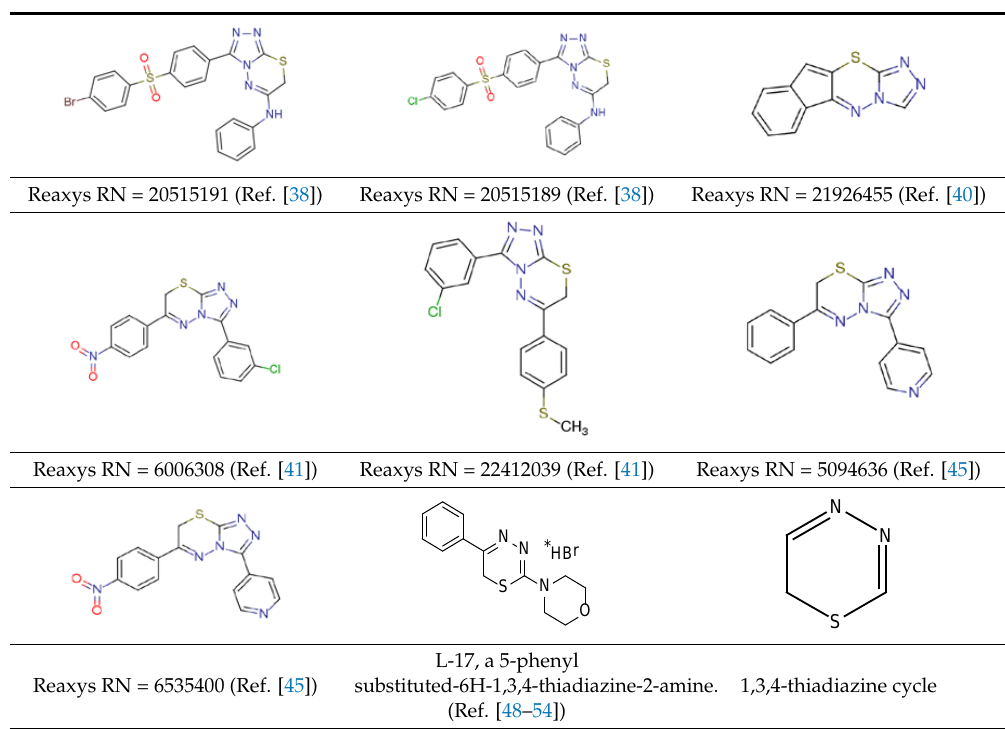
Table 1. Chemical structures of substituted 1,3,4-thiadiazines, mentioned in the text.